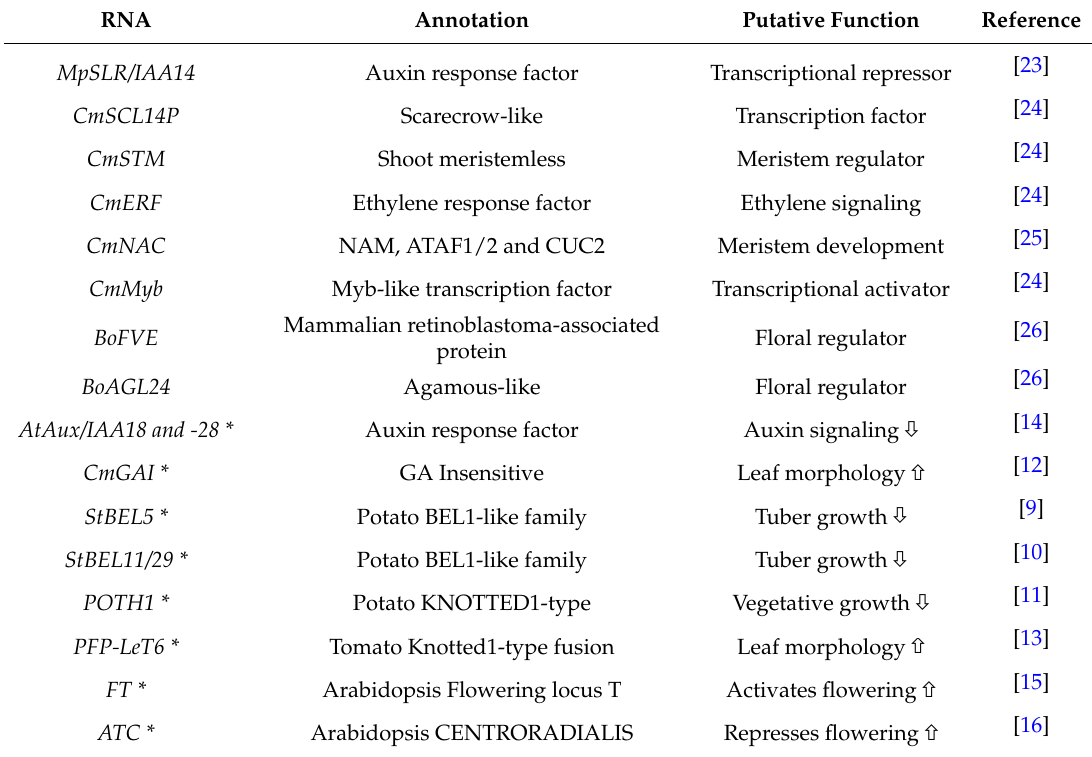
* Indicates that movement of the RNA is associated with a phenotype. At , Arabidopsis thaliana ; Cm, Cucurbita maxima ; Le , Lycopersicon esculentum ; Mp, Malus prunifolia ; Bo, Brassica oleracea ; St, Solanum tuberosum ; PFP, pyrophosphate-dependent fructose 6-phosphate phosphotransferase. Arrows in the function column of the last